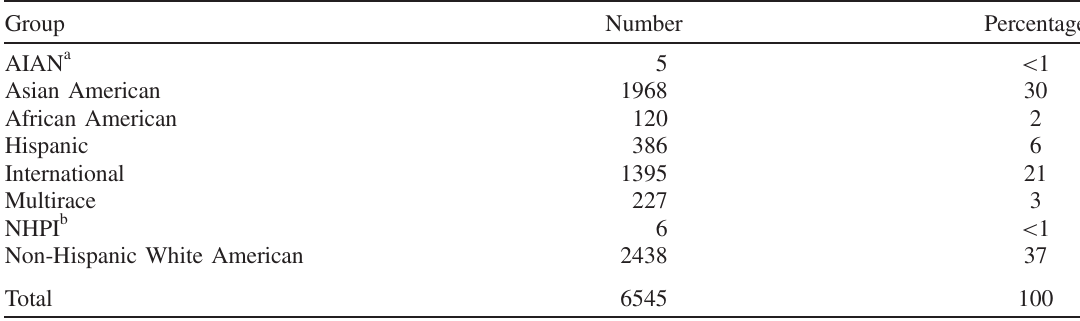
TABLE IX. Student demographics, fall data.